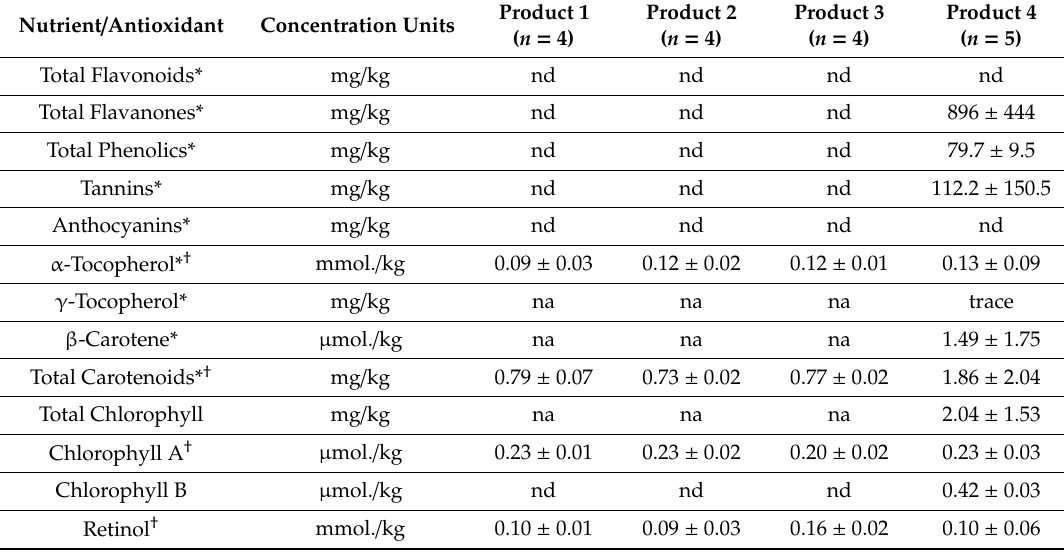
Table 1. Mean ± standard deviation (SD) concentrations of flavonoids, flavanones, total phenolics, tannins, anthocyanins, tocopherols, carotenoids, chlorophylls and retinol (vitamin A) for 4 or 5 di ff erent batches of Products 1–4. * Indicates phenolic antioxidant species. † Statistical significance of di ff erences between mean values were α -tocopherol not significant (ns); total carotenoids p < 0.01 (Product 4 > Products 1 ≈ 2 ≈ 3); chlorophyll A ns;